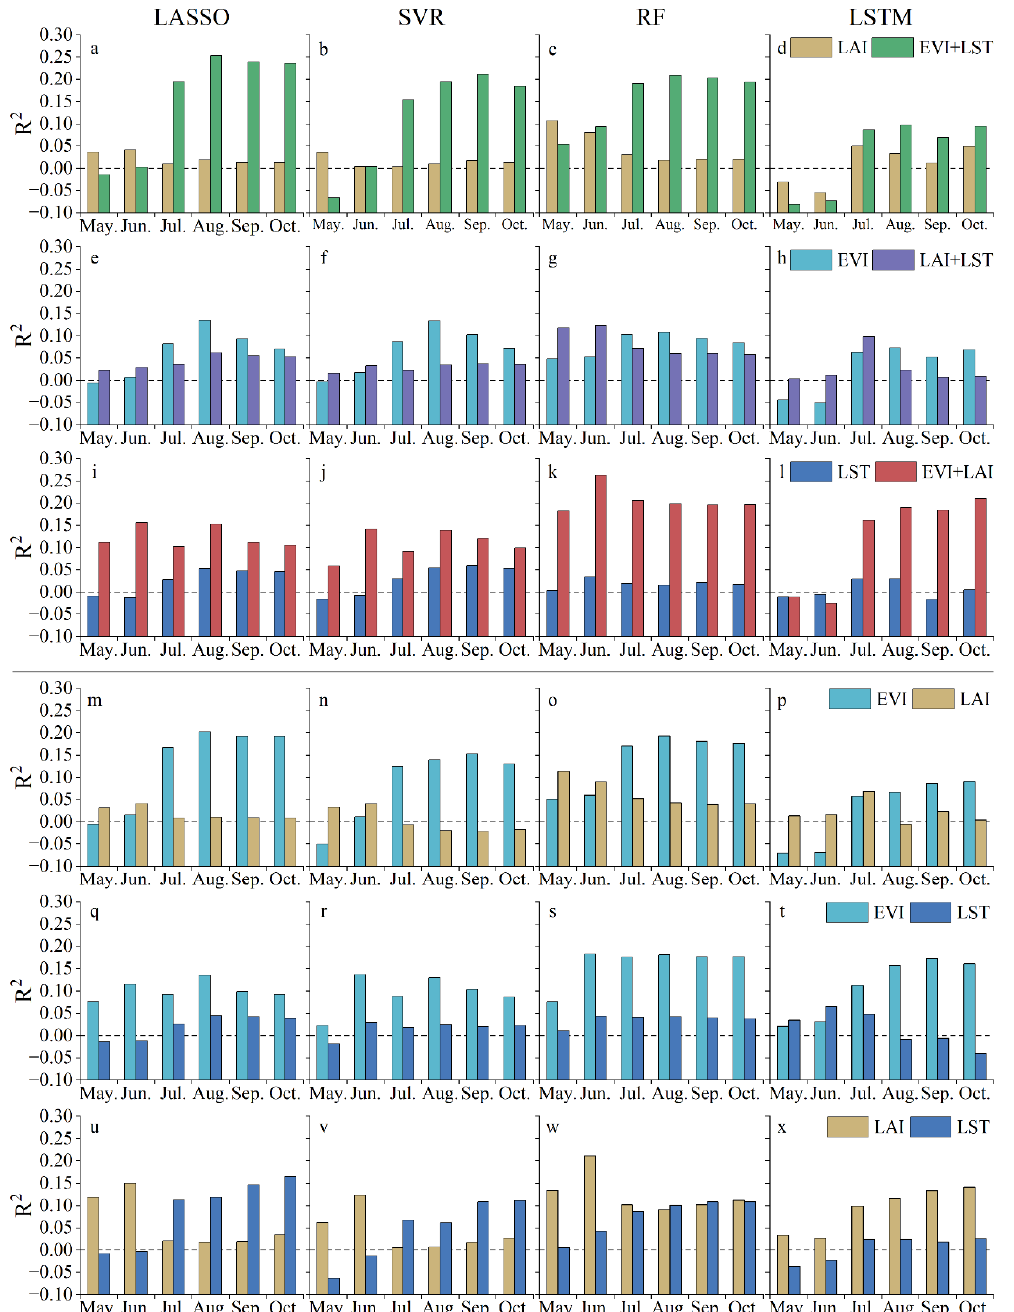
Figure 8. ( a – x ) Temporal differences in model performance for indices (singularly and in combina- tion) over the whole GS in relation to the four methods of analysis (LASSO, SVR, RF and LSTM). ( a – l ) Differences between the three-fold combination EVI + LST + LAI and individual or paired indices. For instance, the LAI column ( a – d ) provides the performance of LAI against the paired indices EVI + LST. The values were calculated by subtracting the line for EVI + LST from that for EVI + LST + LAI in the corresponding panel in Figure 7. ( m – x ) Differences in the per- formance of two indices and single index. For example, the LAI column ( m – p ) indicates the relative performance of LAI which was calculated by subtracting the line of EVI from that of EVI + LAI in the corresponding panel in Figure 7. The dashed lines at R 2 of 0 represent that indices do not provide additional model performance relative to other